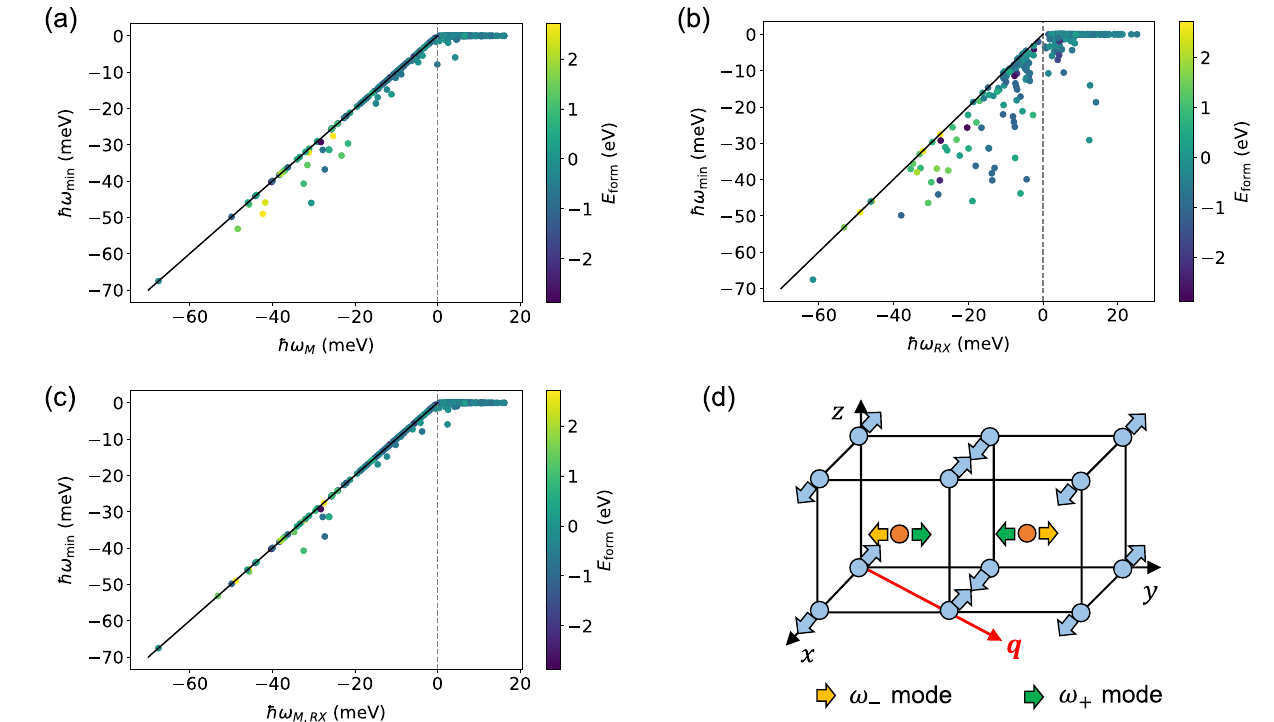
ℏ ω ℏ ω ℏ ω RX , and ( c ) M , RX . The solid line M , ( b ) =